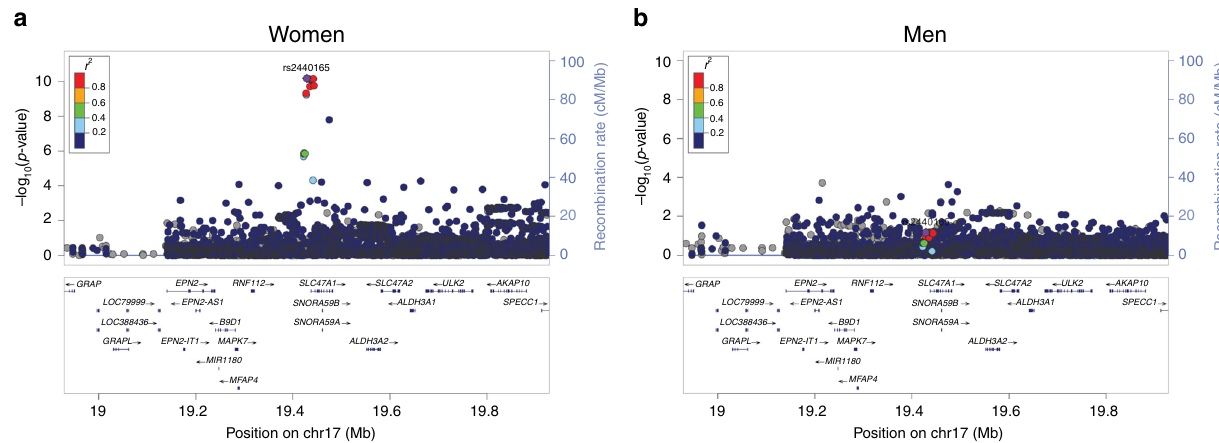
Fig. 3 LocusZoom plots of region showing differential association between sexes. eGFR meta-analysis results in HUNT strati fi ed by sex were fi ltered to identify regions signi fi cant in one sex ( P < 5 × 10 − 8 ) but not signi fi cant ( P > 0.05) in the other. Within each panel, we show regional results for eGFR association for variants near rs2440165, which is an eQTL for SLC47A1, in women ( a ) and men (